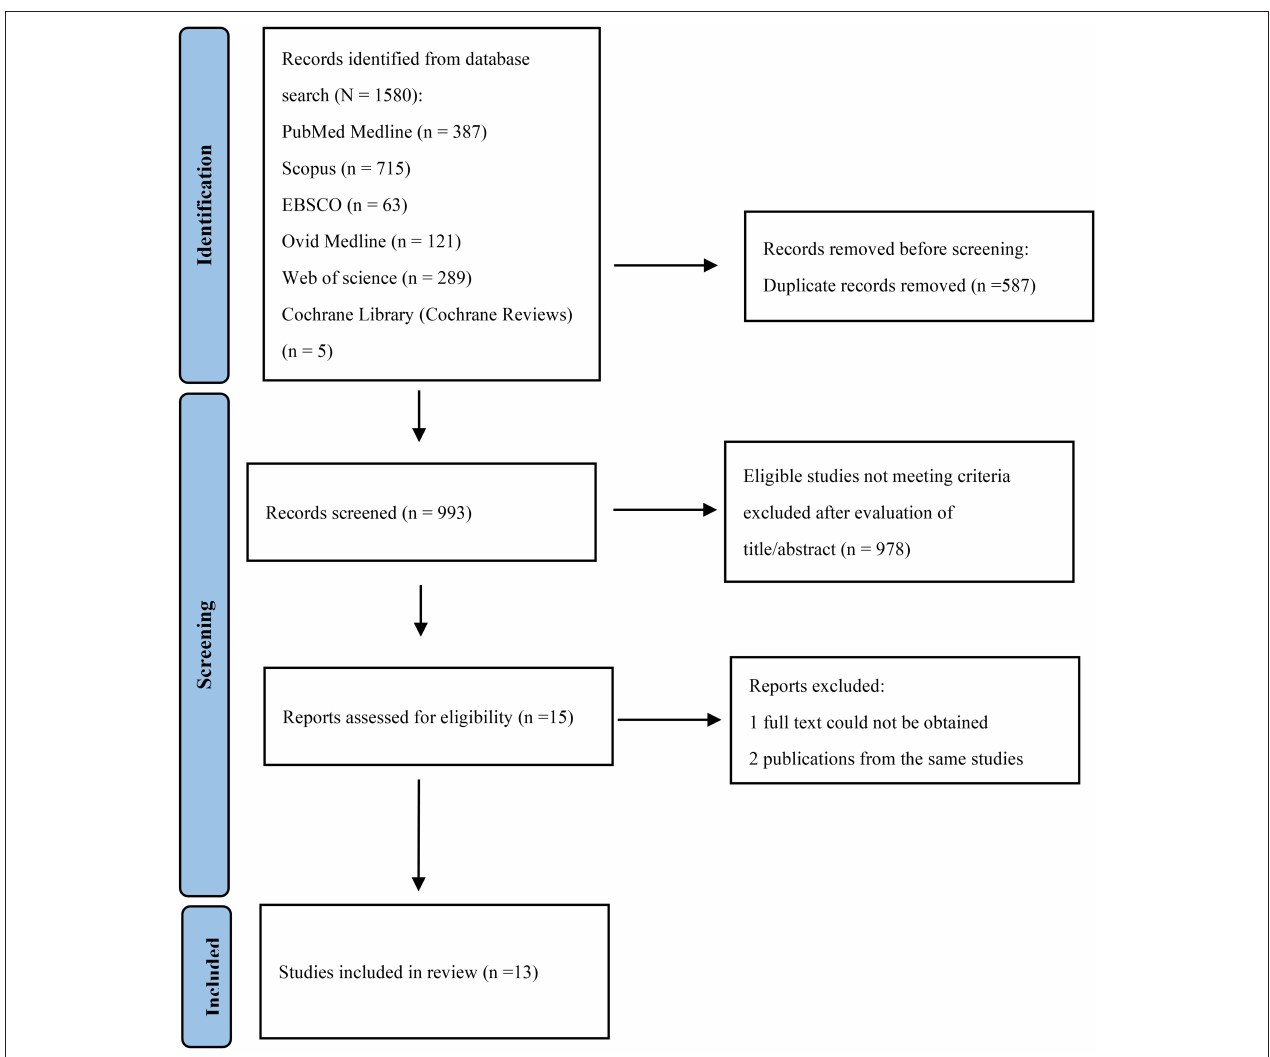
FIGURE 1 | Flow chart depicting the selection of included